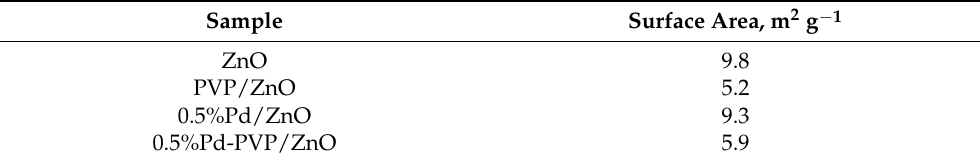
Table 2. BET surface area of the ZnO, 0.5%Pd/ZnO, PVP/ZnO, and 0.5%Pd-PVP/ZnO samples.